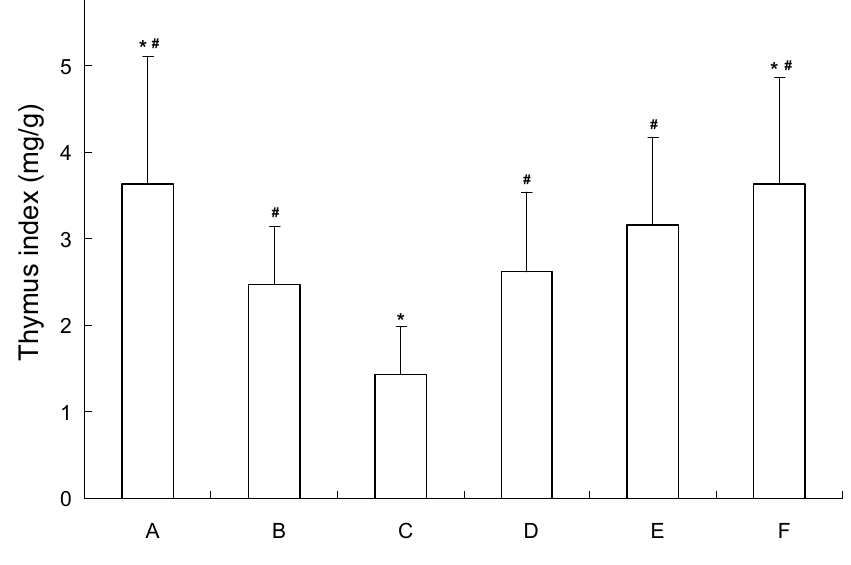
Figure 4. Influence of CE-SB on immune organs and WBC count of H22 bearing mice. Group A: normal control; Group B: tumor control; Group C: 5-FU; Group D: low dosage CE-SB; Group E: medium dosage CE-SB; Group F: high dosage CE-SB. * P < 0.05 vs . tumor control group; # P < 0.05 vs . 5-FU